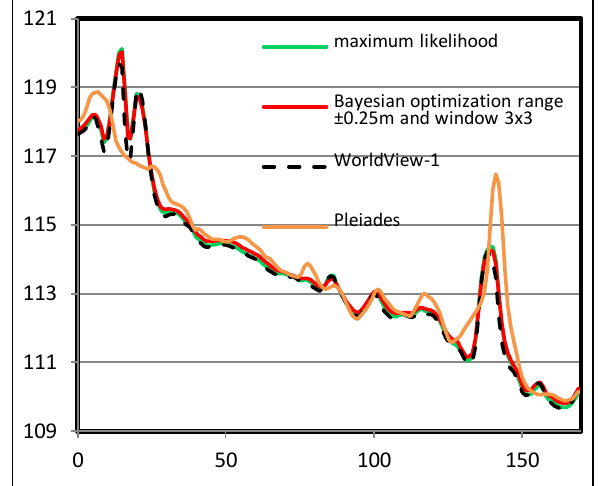
Figure 6. Profile for height